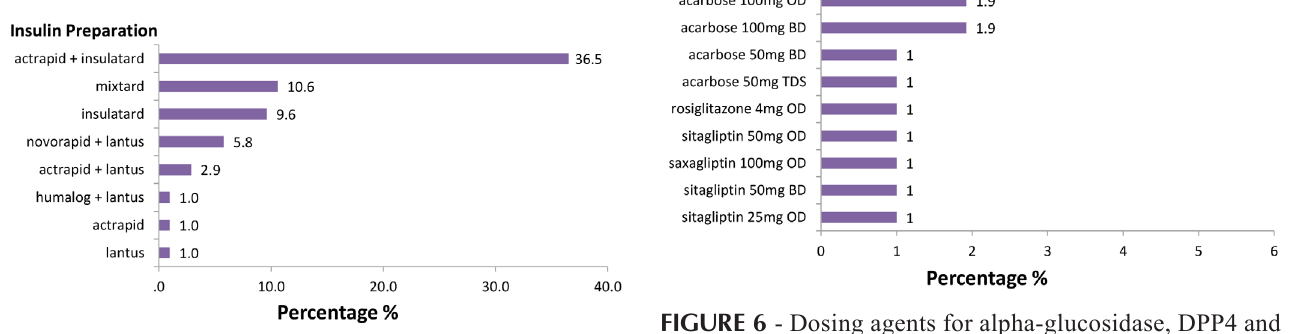
FIGURE 3 - Insulin preparation used for T2DM patient with DR